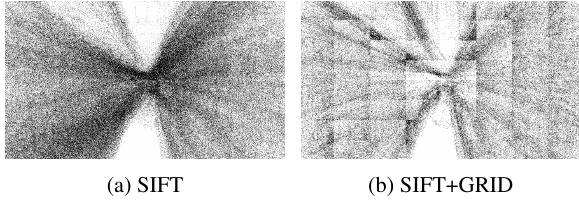
Figure 1. The density maps of interest